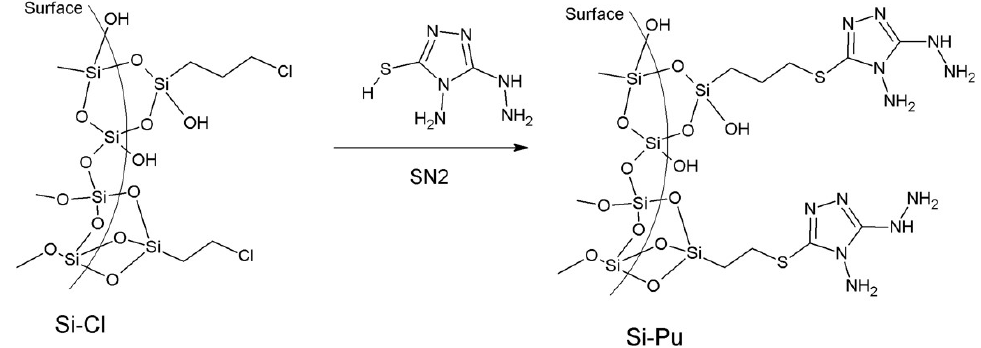
Figure 2. Modification reaction of the Si ‐ Cl material in the presence of the ligand molecule (Purpald) to obtain the material Si ‐ Pu.